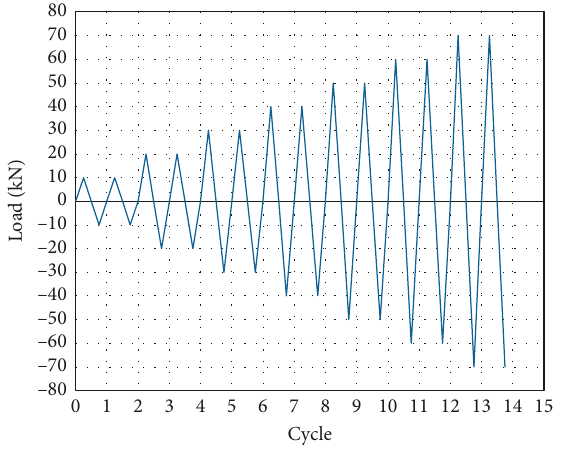
Figure 7: Load cycle graphics.